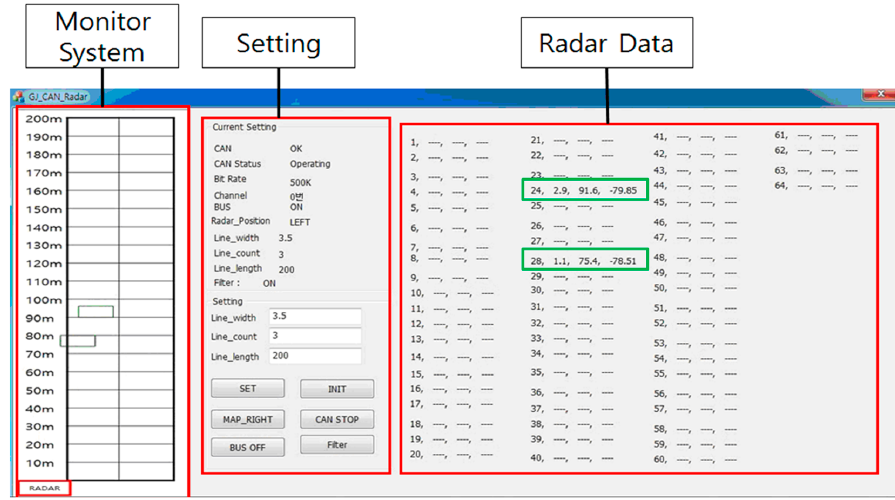
Figure 6. Graphical User Interface (GUI) for range configuration and display.